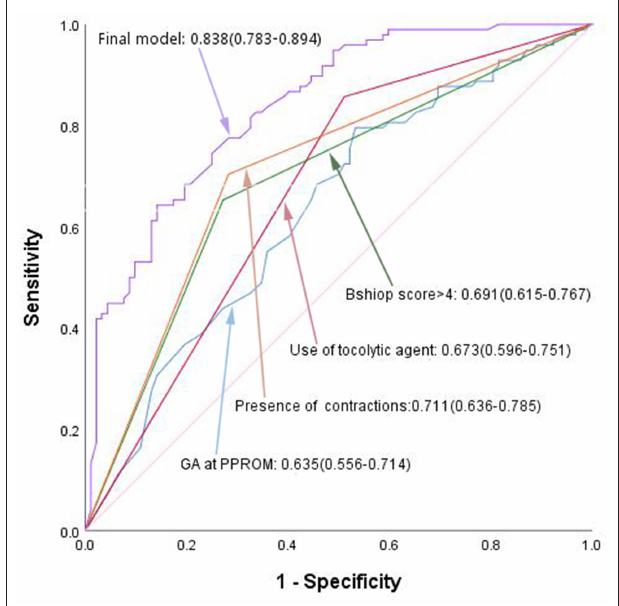
FIGURE 1 | ROC curves of the final predictive model, compared to separate independent predictor. GA, gestational age; PPROM, preterm premature rupture of